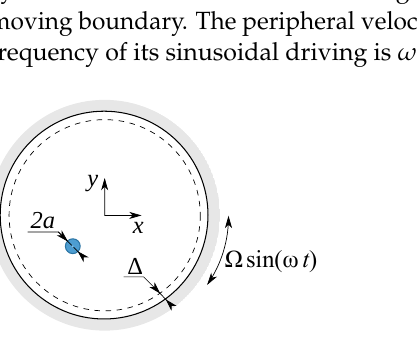
Figure 1. Schematic of a small single particle (light blue) moving in an incompressible fluid flow confined in a hollow cylinder and driven by the rotation of the cylinder